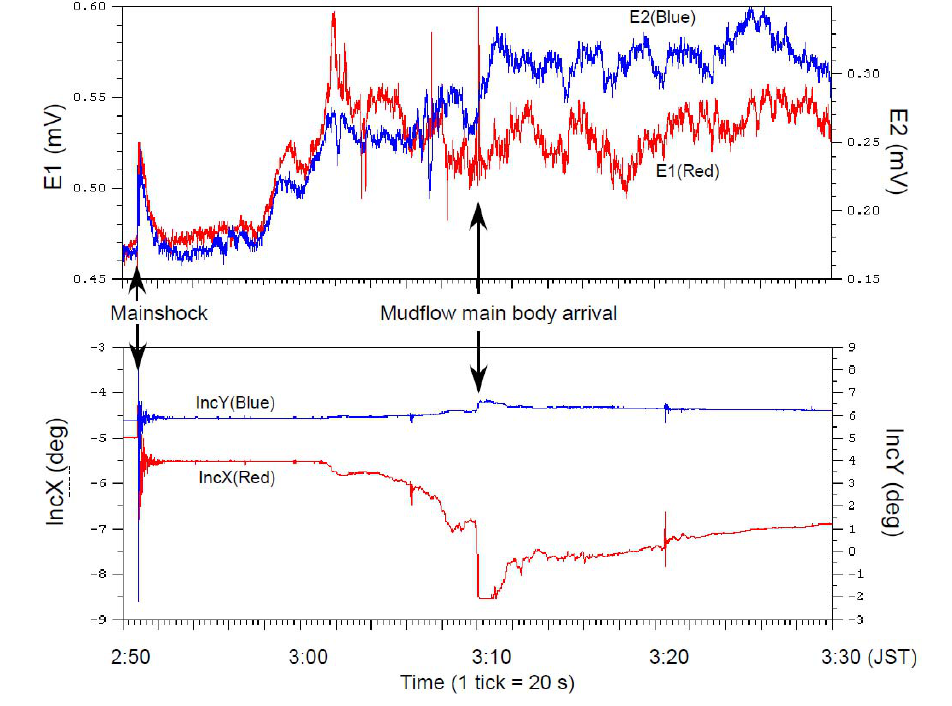
Figure 10. Time variations deduced by OBEM after the earthquake. The upper panel shows two electrical components; the lower panel shows inclinometer